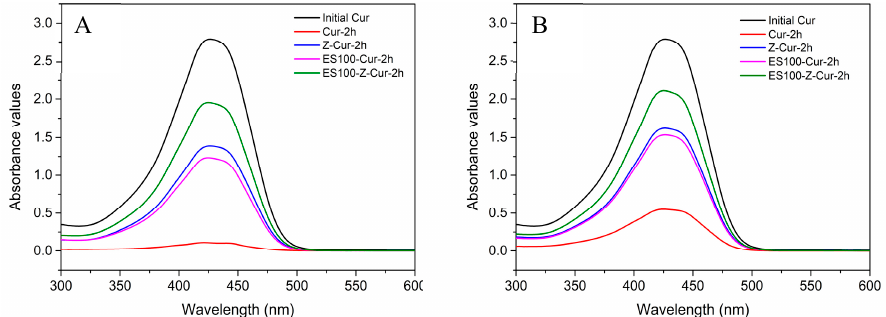
Figure 7. Absorption spectra of Cur, released self-assembled Z–Cur, ES100–Cur, ES100–Z–Cur prepared in ethanol after ( A ) UV treated 2 h, ( B ) 80 °C treated 2 h.